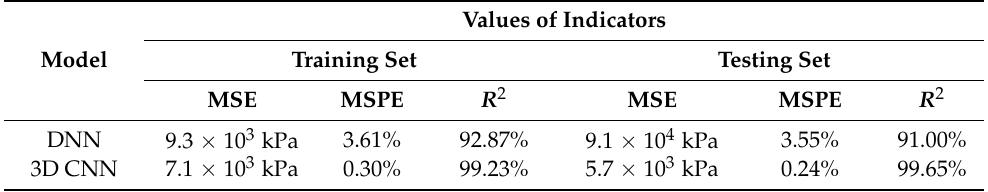
Table 2. Evaluation indicators of the deep learning models. Values of Indicators Training Set Testing Model